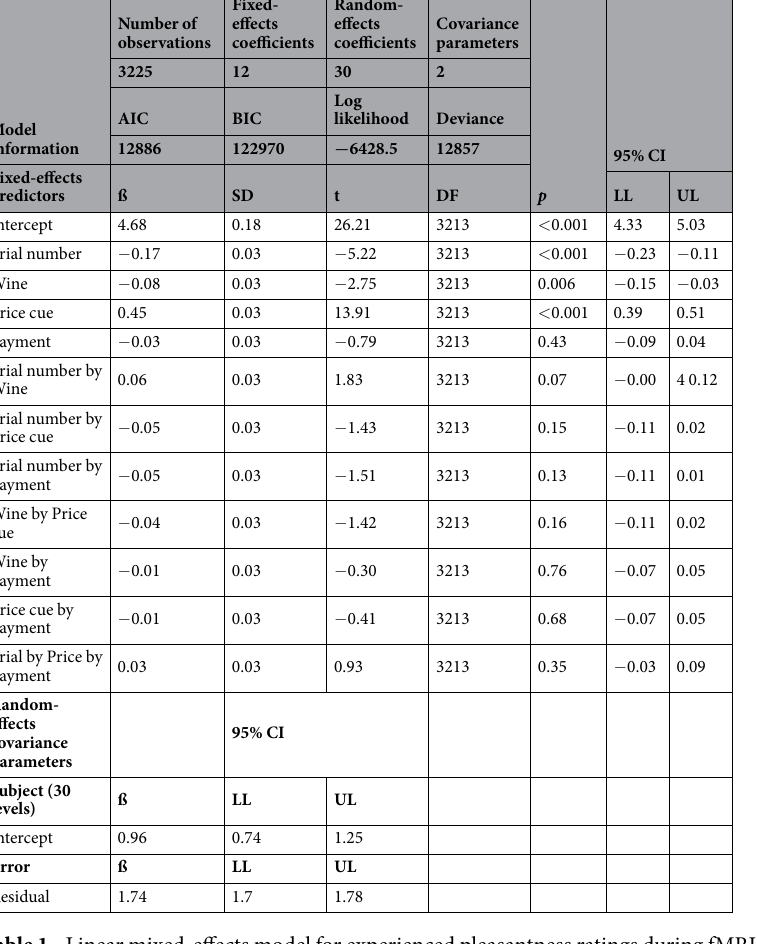
Supplementary Fig. S1). Moreover, we compared ratings influenced by price cues to baseline ratings that were sampled in a blind tasting a week after the fMRI session (M blind = 5.03, SEM = 0.23). This comparison revealed that the price cue effects were driven by decreases in experienced pleasantness of low-priced (€3, M informed = 4.19, SEM = 0.20) wines rather than increases in experienced pleasantness of high-priced (€18, M informed = 5.21, SEM = 0.21) wines (paired, two-tailed t -test: €3 M informed-blind = − 0.83, SEM = 0.28 vs. €18 M informed-blind = 0.18, SEM = 0.30, t (29) = − 5.2, p < 0.001) (see Supplementary paragraph 1.2 and Fig. S2).